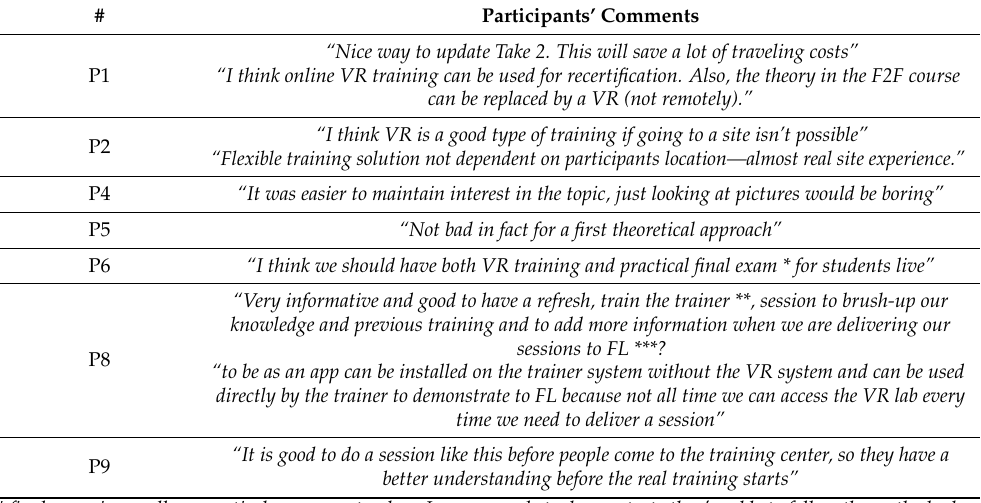
Table 2. Quotes from